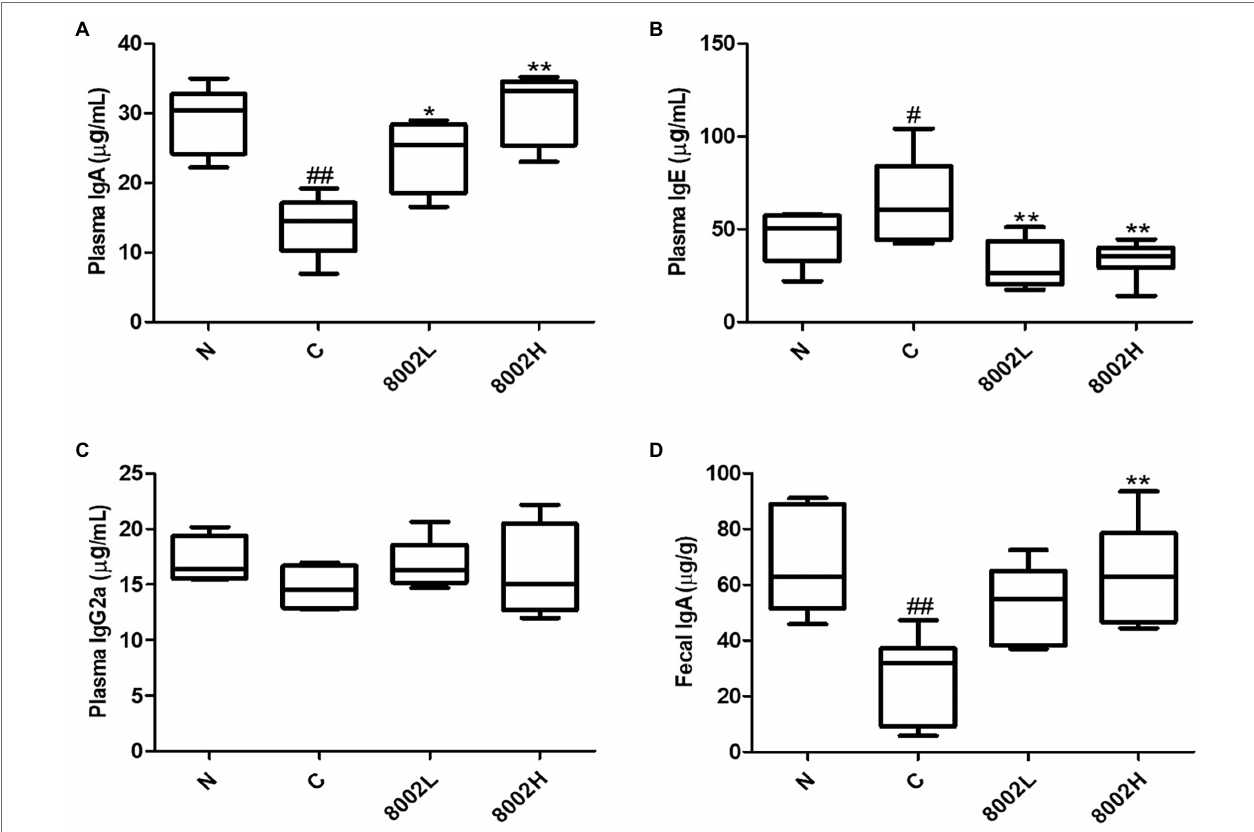
FIGURE 7 | Effect of HY8002 administration on plasma (A) IgA, (B) IgE, (C) IgG2a, and (D) fecal IgA in kanamycin-treated mice. The results are expressed as Box and Whisker Plots (median with minimum to maximum values). * p < 0.05 and ** p < 0.01 compared with kanamycin-treated control groups. # p < 0.05 and ## p < 0.01 compared with normal groups. N, normal group ( n = 8); C, kanamycin administration group ( n = 8); 8002L, kanamycin with 1.0 × 10 8 CFU/kg/day HY8002 administration group ( n = 8); 8002H, kanamycin with 1.0 × 10 9 CFU/kg/day HY8002 administration group ( n =